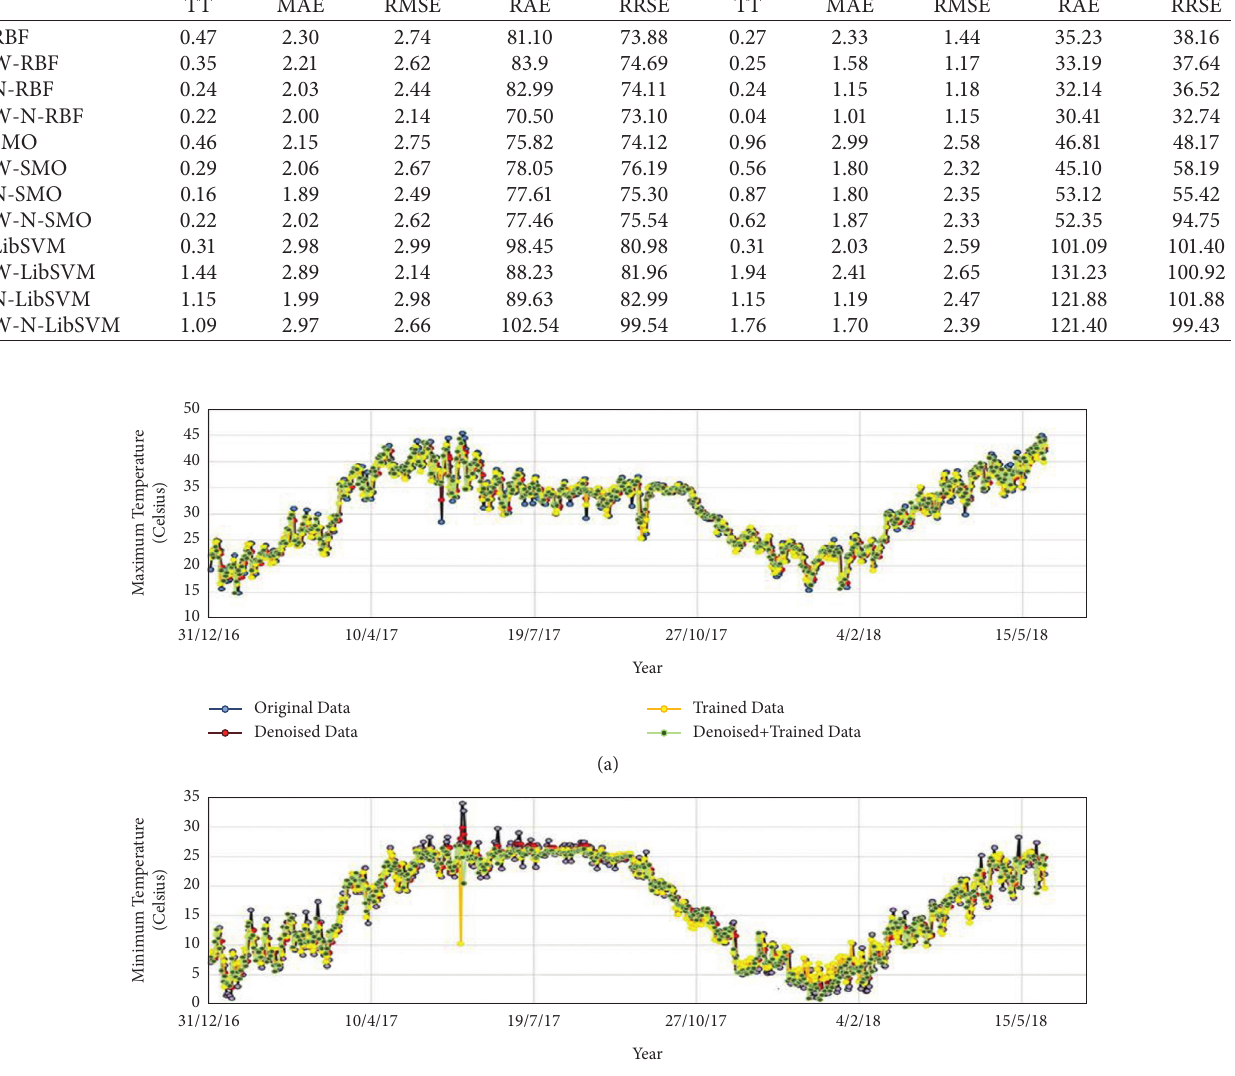
Table 7: Comparison of errors and time taken for minimum temperature, Mumbai and Chennai.